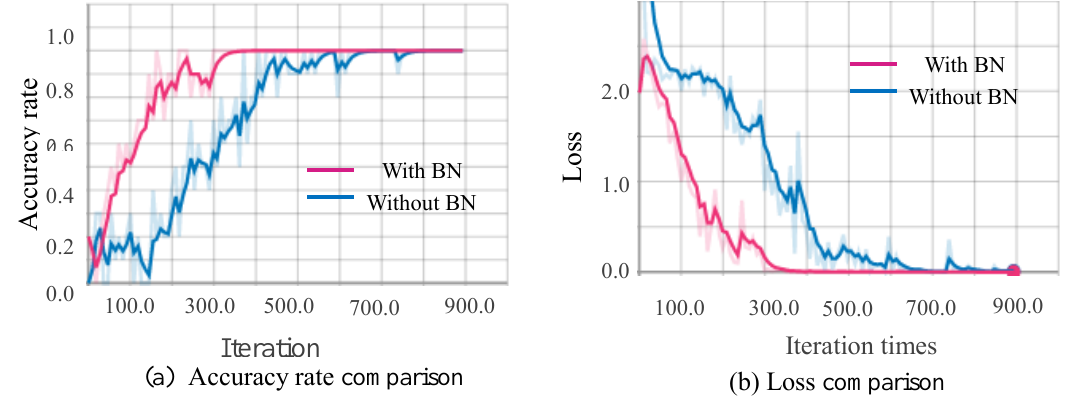
Figure 11. Comparison curves for the binary image.